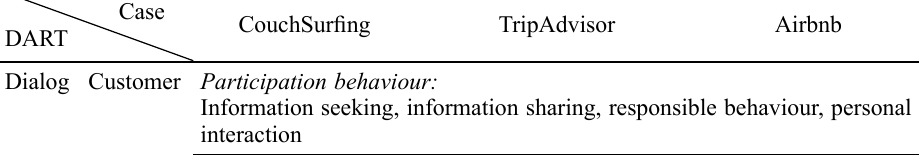
Table 3. Results of cases study: DART model application in of online travel service providers Case DART